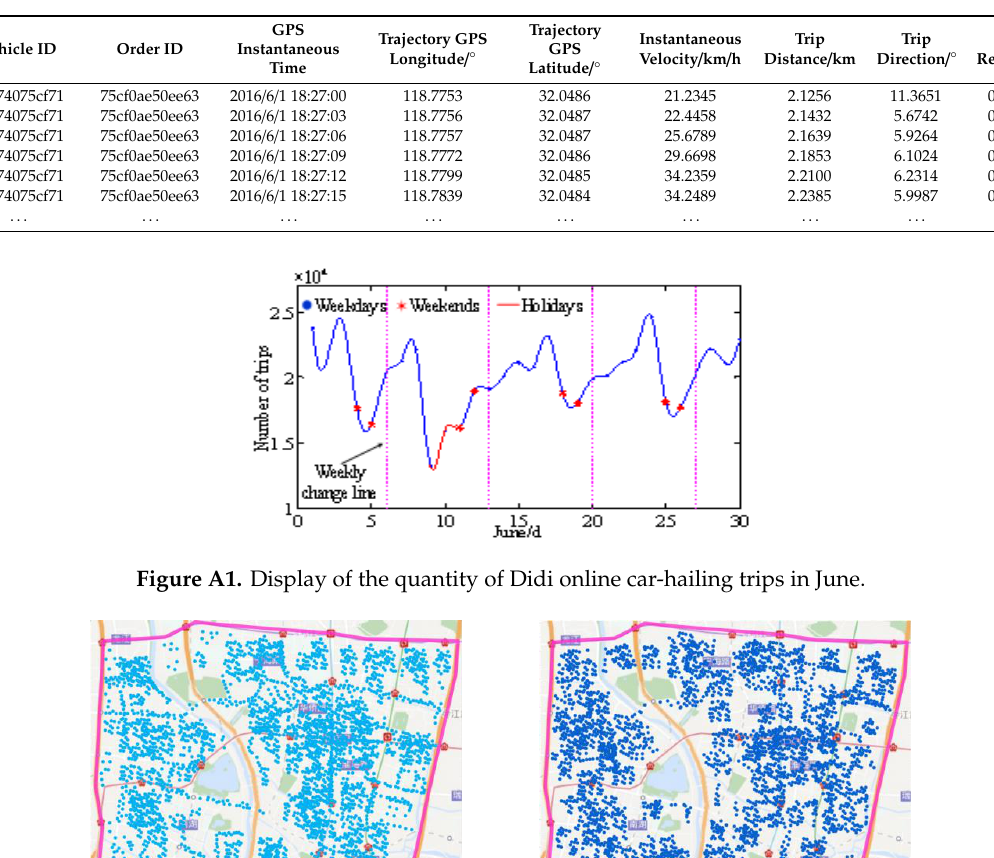
Table A2. Example of Didi trip data.